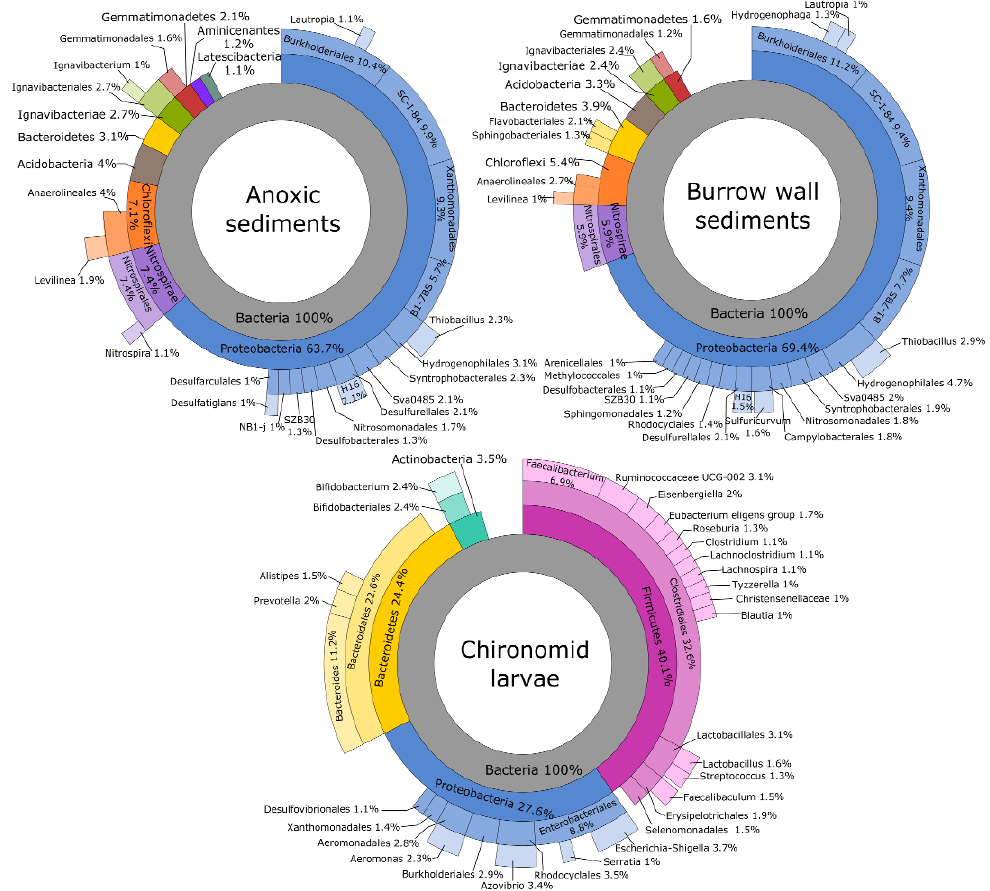
Figure 1. Scheme of the experimental set up. Figure 3. Overview of the bacterial community composition detected using the 16S rRNA marker gene in anoxic sediments, burrow wall sediments and chironomid larvae. The charts show the relative abundance of sequences at di ff erent taxonomic levels. To aid in visualization, taxa contributing < 0.1% are not shown. The inner circle demonstrates the percentage of taxa assigned at the highest level